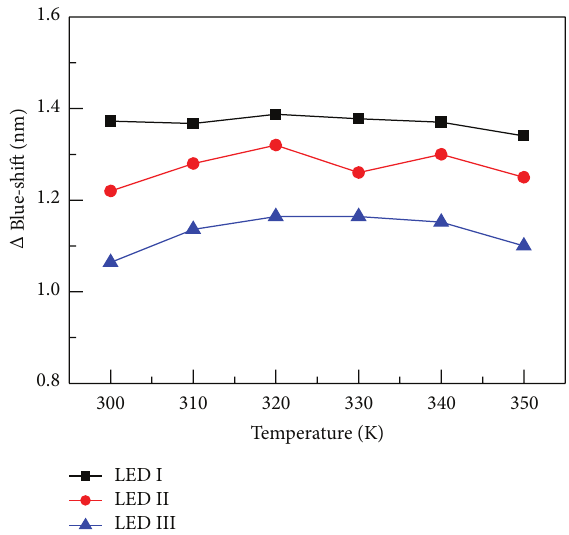
Figure 6: The turning points of injection currents (i.e., wavelength transition position from blue-shift to red-shift as shown by the dashed lines in Figures 4(a)–4(c)) as functions of ambient tempera- tures for the three fabricated